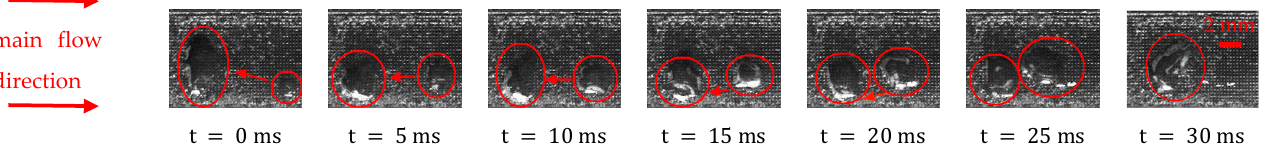
Figure 15. Top view when Re = 11,000.